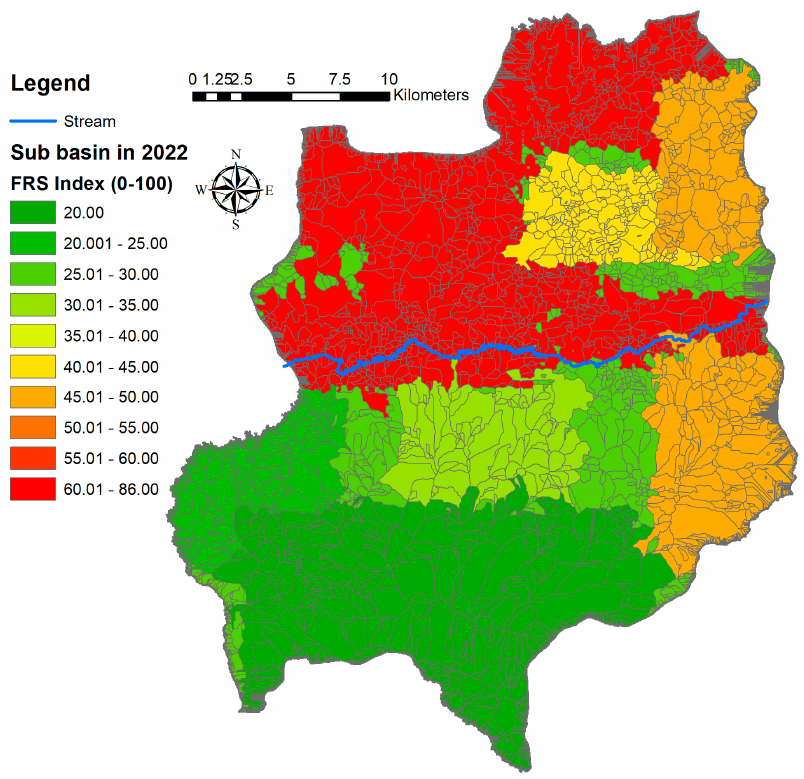
Figure 9. Map of flood risk susceptible forecast using FRS -GWR model in 2022 .